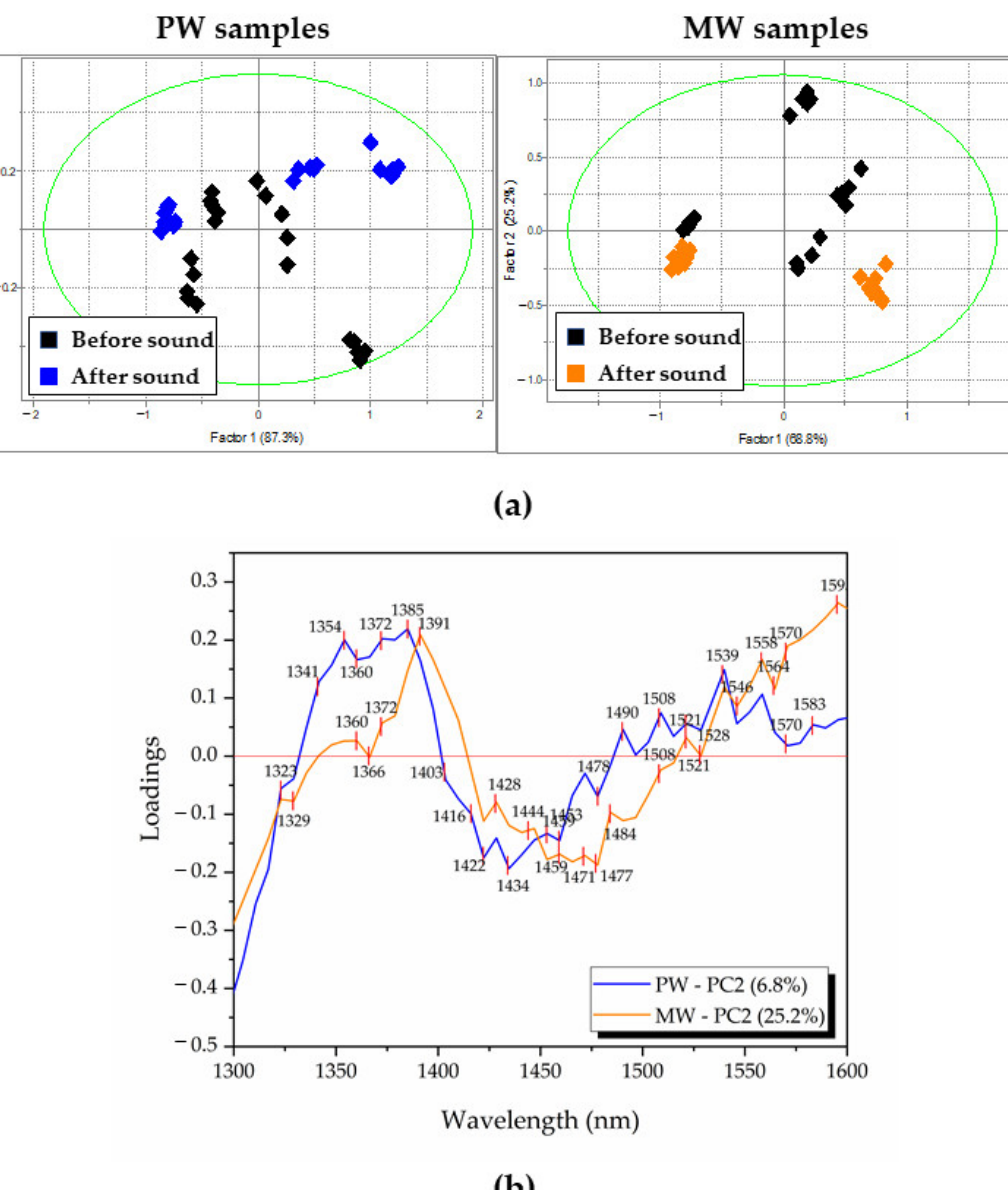
Figure 3. Score plots of PCA analysis of raw spectra preprocessed with SNV for separate PW and MW datasets: ( a ) Score plots for PW data ( left ) and MW ( right ); ( b ) PCA loadings describing influence of sound at PC2 for both waters (positive peaks are related to samples after sound perturbation).